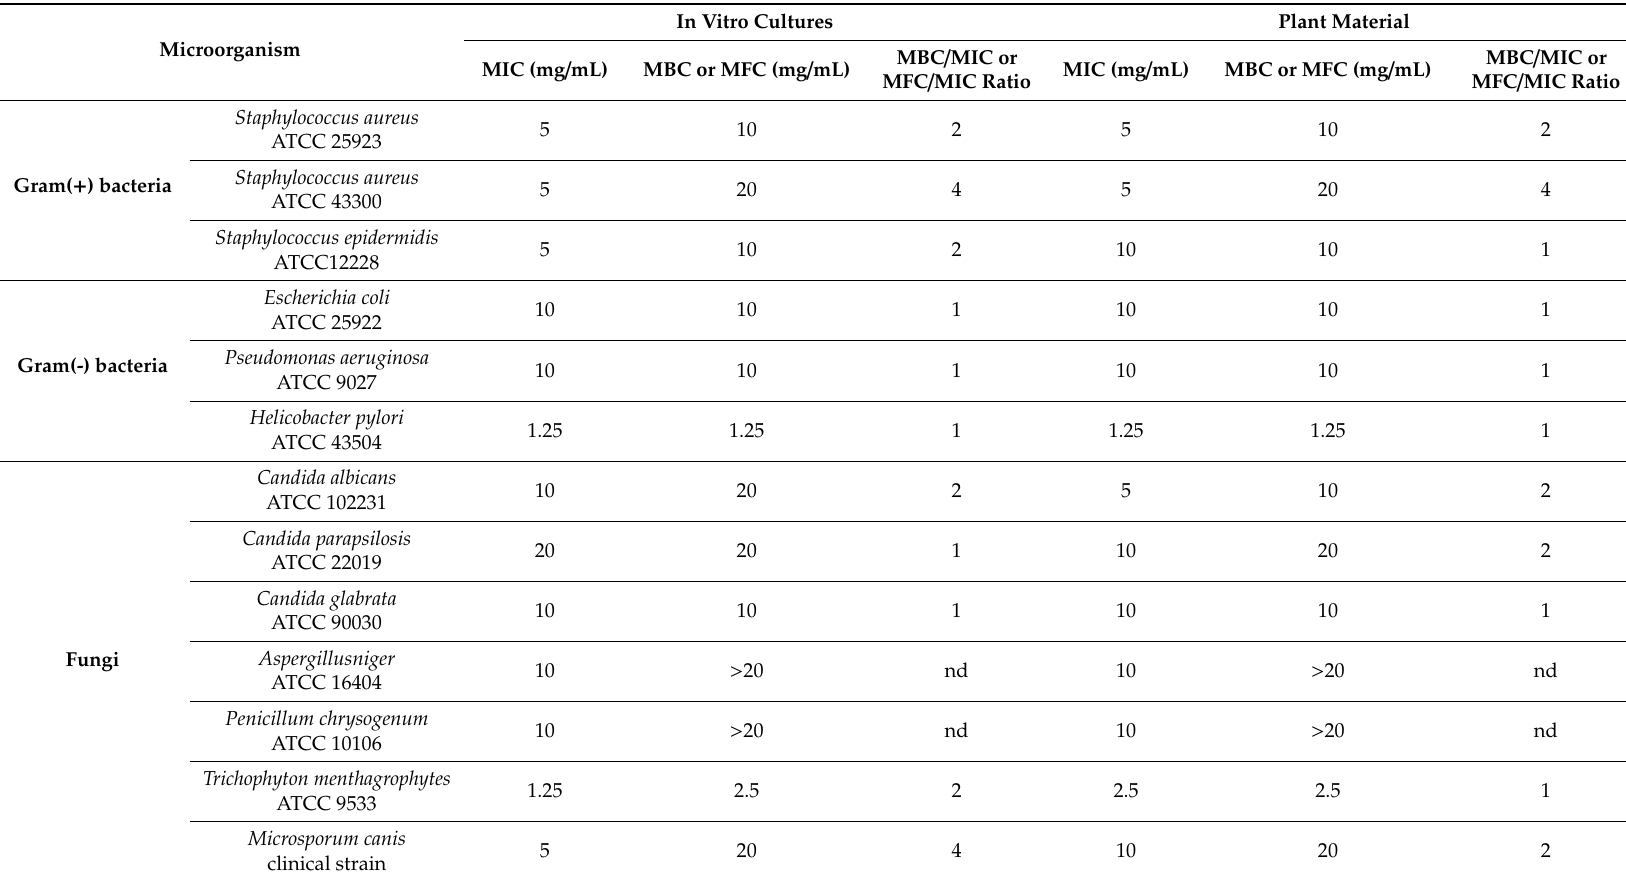
Table 6. Antimicrobial activity of studied extracts from N. o ffi cinale microshoot cultures grown in RITA ® bioreactors over 10 days growth periods, and N. o ffi cinale herb extracts, against selected bacterial and fungi